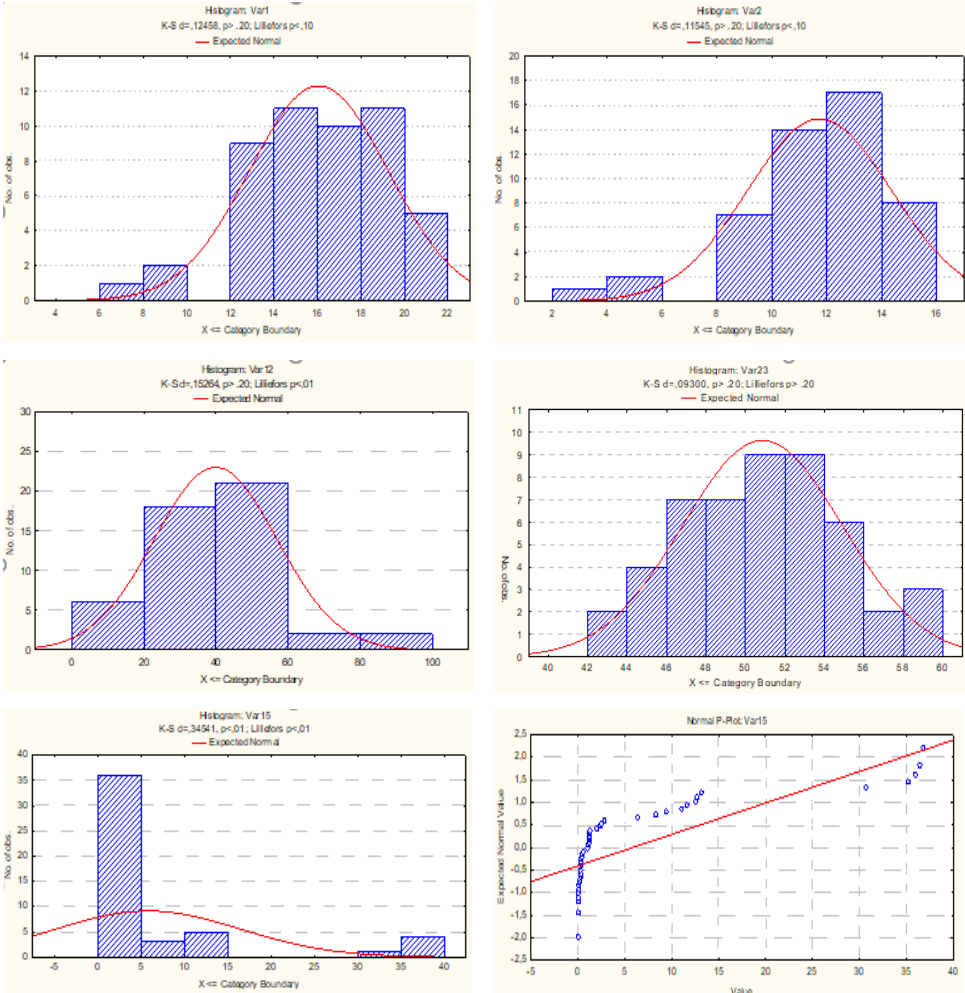
Figure 1. The results of tests for the normality of the analyzed variables